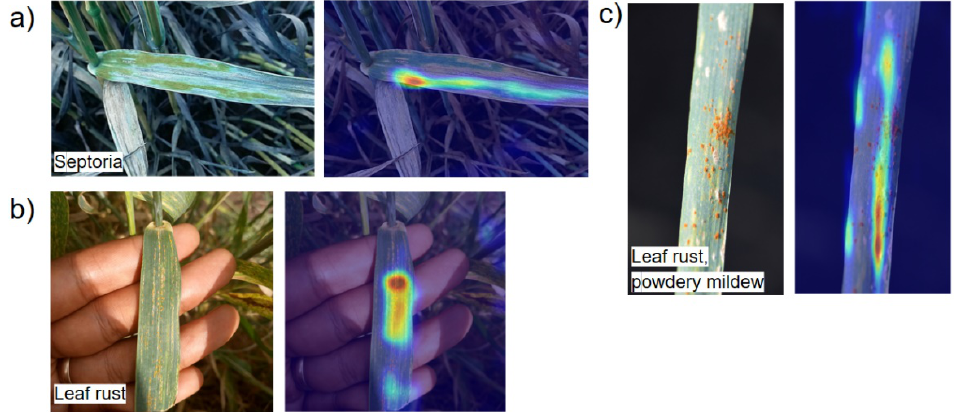
Figure 8. Visualization of the activation maps for three images with disease symptoms by Grad-CAM: ( a ) septoria, ( b ) leaf rust, and ( c ) leaf rust and powdery mildew. The original image is shown in the left part of the panel, and the activation map diagram is shown on the right part of the panel. The level of the activation is shown by color from low (blue) to high (red) values.